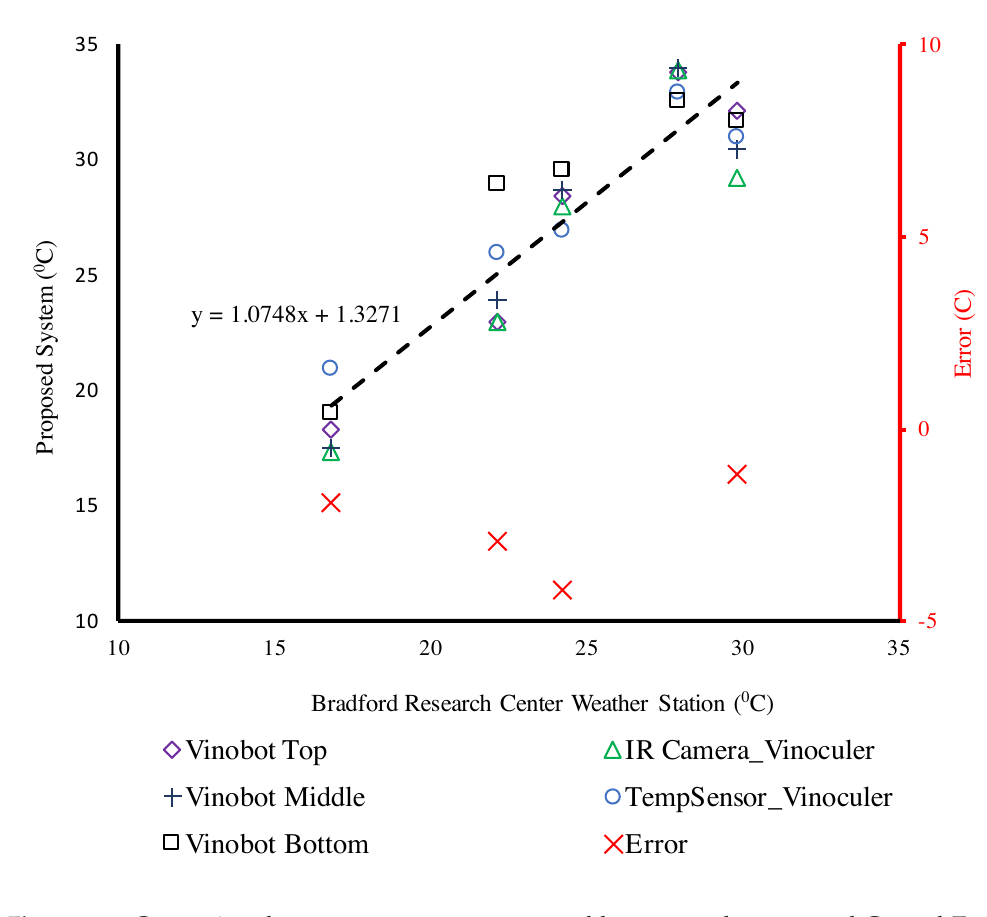
Figure 21. Comparison between temperature measured by proposed system and Ground Truth (Bradford Weather Station